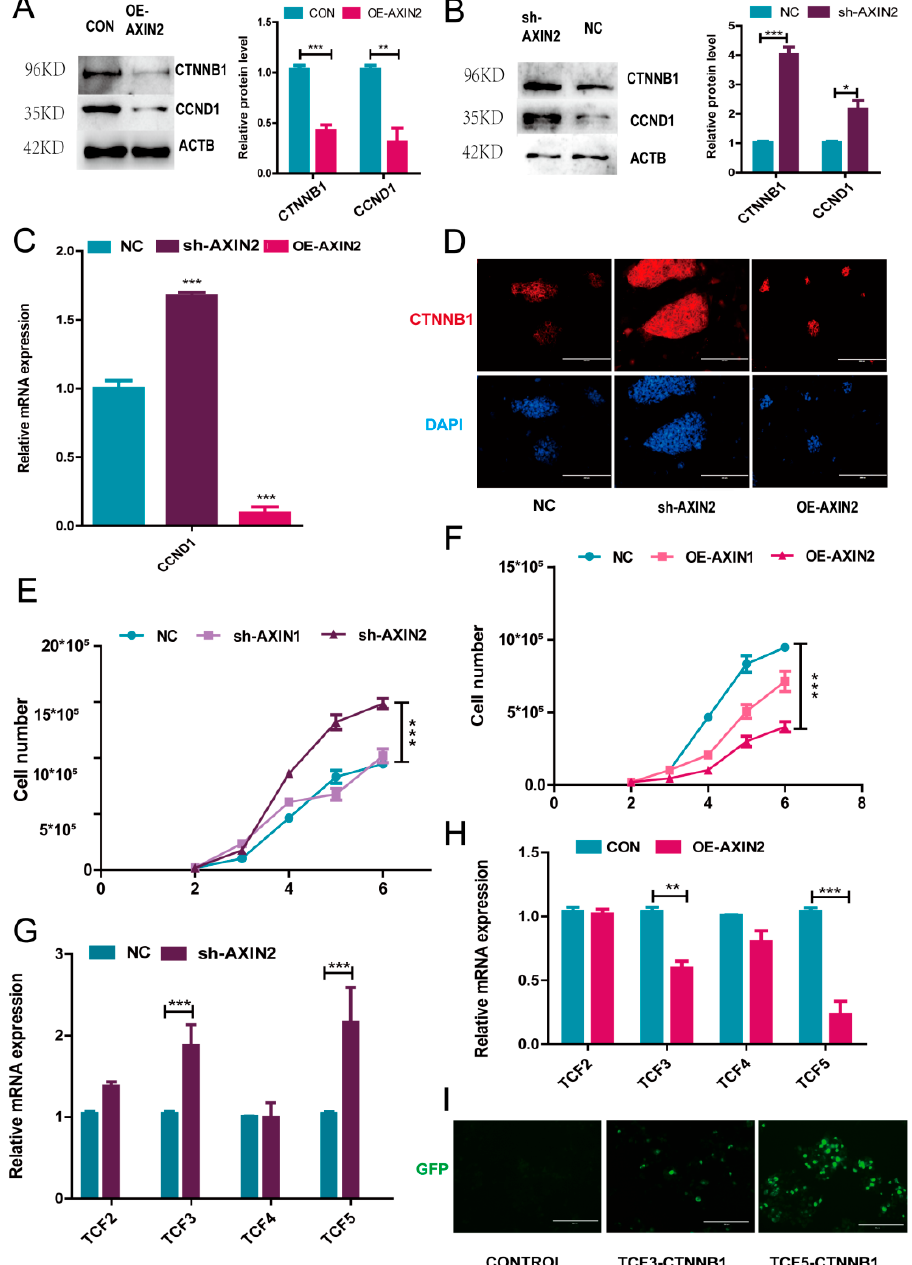
Figure 4. AXIN2 affects cell proliferation through CCND1 . ( A ) Western blot analysis of CTNNB1 and CCND1 in the CON and OE-AXIN2 groups; ( B ) western blot analysis of CTNNB1 and CCDN1 in the NC and sh-AXIN2 groups; ( C ) qPCR analysis of CCND1 in the NC, sh-AXIN2, and OE-AXIN2 groups; ( D ) representative image of CTNNB1 immunofluorescence in the NC, sh-AXIN1, and OE-AXIN2 groups; the scale bar represents 200 µ m; ( E ) cell growth curve of NC, sh-AXIN1, and sh-AXIN2; *** represents p < 0.0001; ( F ) cell growth curve of CON, OE-AXIN1, and OE-AXIN2 groups; *** represents p < 0.0001; ( G ) qPCR analysis of TCF2, TCF3, TCF4, and TCF5 in the NC and sh-AXIN2 groups; ( H ) qPCR analysis of TCF2, TCF3, TCF4, and TCF5 in the CON and OE-AXIN2 groups; ( I ) representative images of BiFC analysis in CONTROL, TCF3-CTNNB1, and TCF5-CTNNB1 293T cells; the scale bar represents 200 μ m. * represents p < 0.05, ** represents p < 0.001, and *** represents p < 0.0001 .